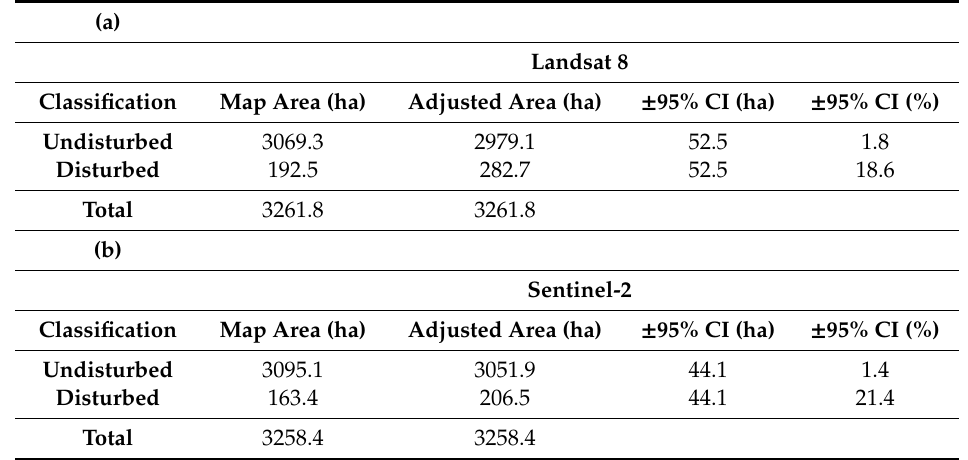
Table 3. Mapped and adjusted areas for the maps of forest canopy disturbance obtained from Landsat 8 ( a ) and Sentinel-2 data ( b ). CI: Confidence interval.